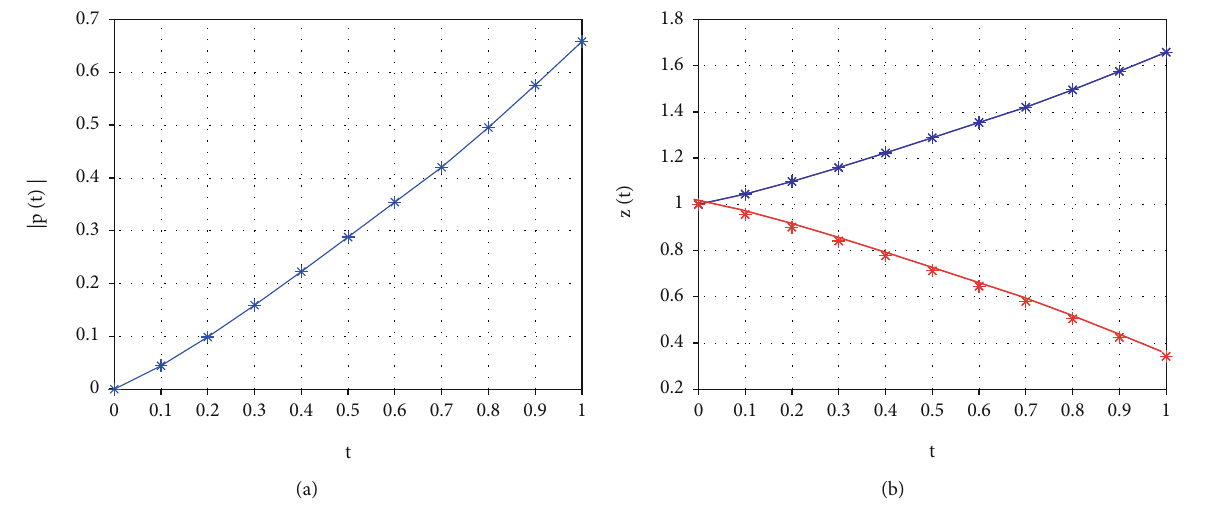
Figure 3: (a) The function j p ð t Þj for t ∈ ½ 0, 1 (cid:2) . (b) The function z ð t Þ for t ∈ ½ 0, 1 (cid:2)